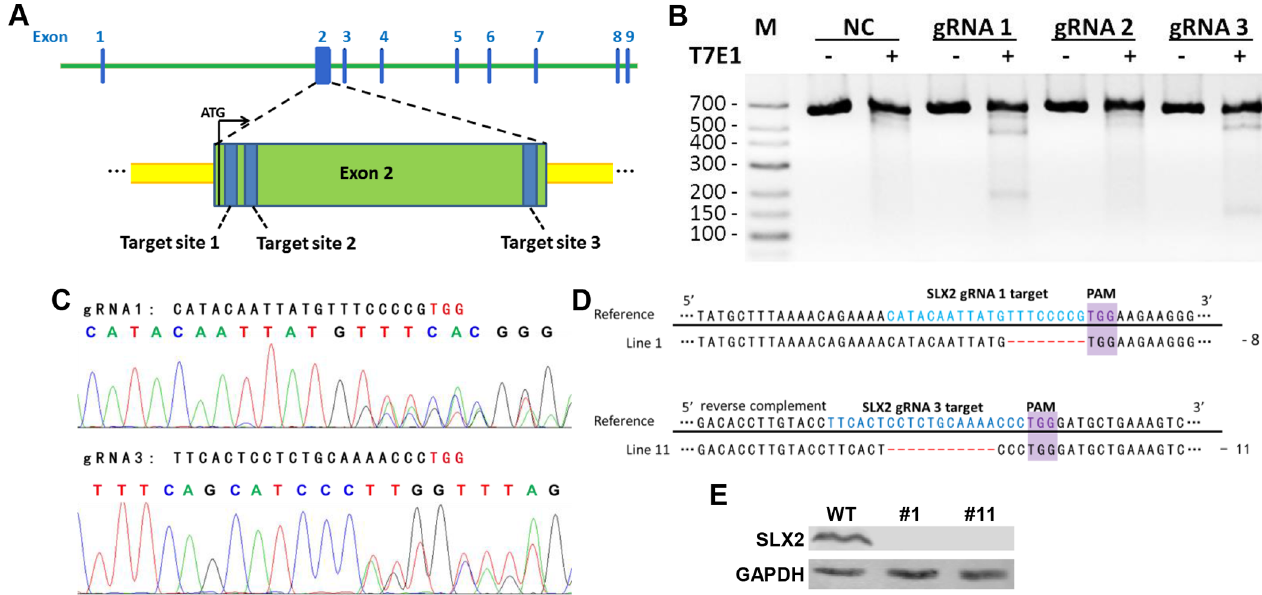
Fig 2. Generation of Slx2 knockout mice. A) Schematic of the genomic target sites in the Slx2 gene. B) Analysis of CRISPR/Cas9 system efficiency in mouse embryonic stem (ES) cells by using T7E1 assay. pX330 ligated with different gRNAs were transfected into V6.5 ES cells. Targeted region was PCR amplified and then digested by T7 Endonuclease I. M, marker. NC, negative control, mouse ES cells transfected with GFP plasmid. C) gRNA-1 and gRNA-3 worked in mouse embryos. Sequencing results of mouse embryos injected with Cas9 mRNA and Slx2 gRNA-1 or gRNA-3 were shown. D) Genotyping results of line 1 and line 11 F1 mice. Cas9-mediated indels lead to frame shift of Slx2 . Blue color showed the sequence of gRNAs; protospacer adjacent motifs (PAM) were labeled with purple color; red color showed the modified sequences information after targeting. -, nucleic acid base deletion. E) Western blot analysis of SLX2 expression level in testis from line 1 (#1) and line 11 (#11) mice. WT, wild-type.